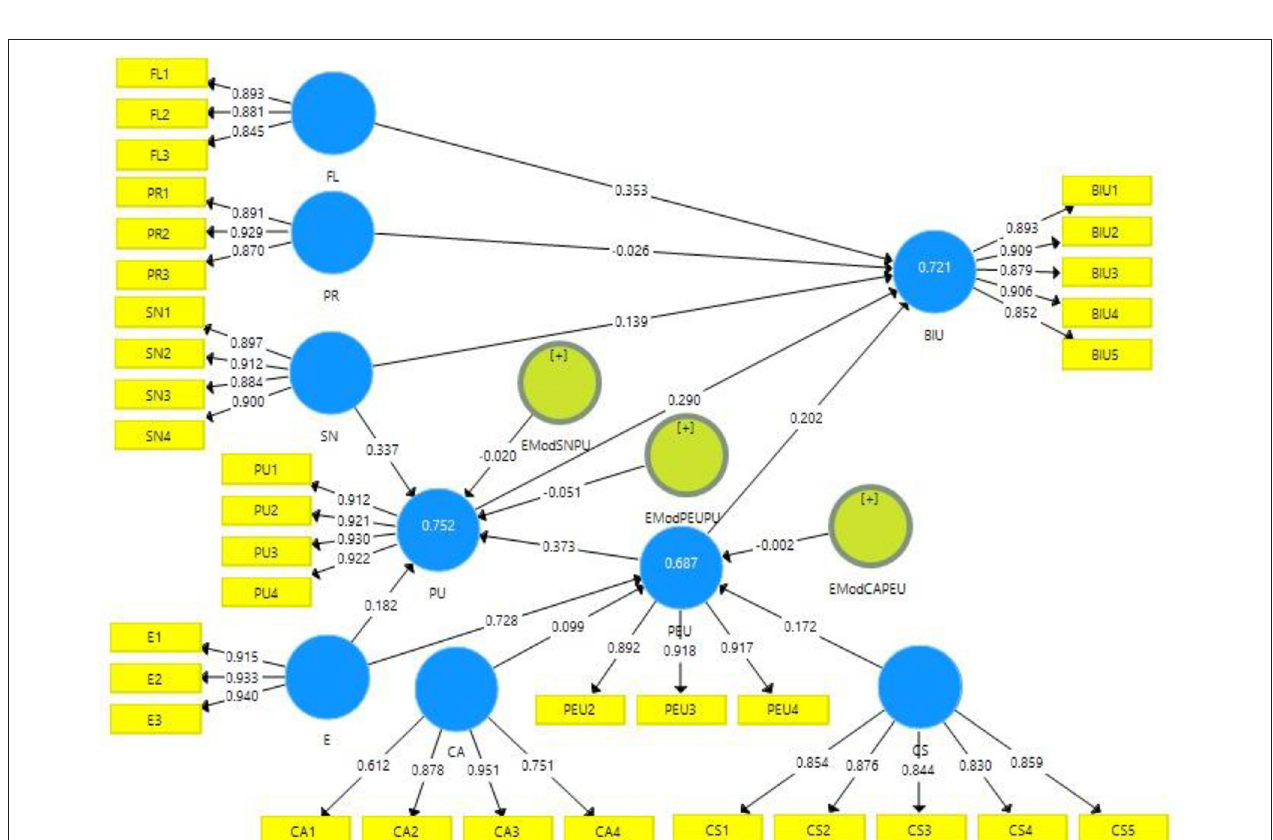
FIGURE 3 | Measurement